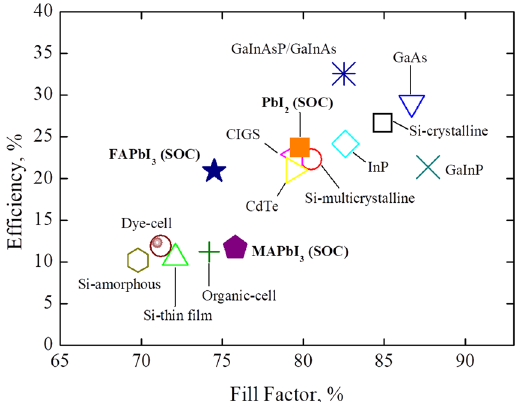
Fig. 9 Ef fi ciencies of solar cells tested under one sun terrestial irradiance AM1.5 spectrum (1000W/m 2 ) at 25°. We summarise the relation of best reported ef fi ciencies ( y -axis) vs fi ll factor ( x -axis) which gives a relation of the maximum power achived by the cell. Solid symbols show the lead- based organometal halide perovskites which posses strong spin – orbit coupling (SOC). The plotted data are based on tables reported in ref. 60